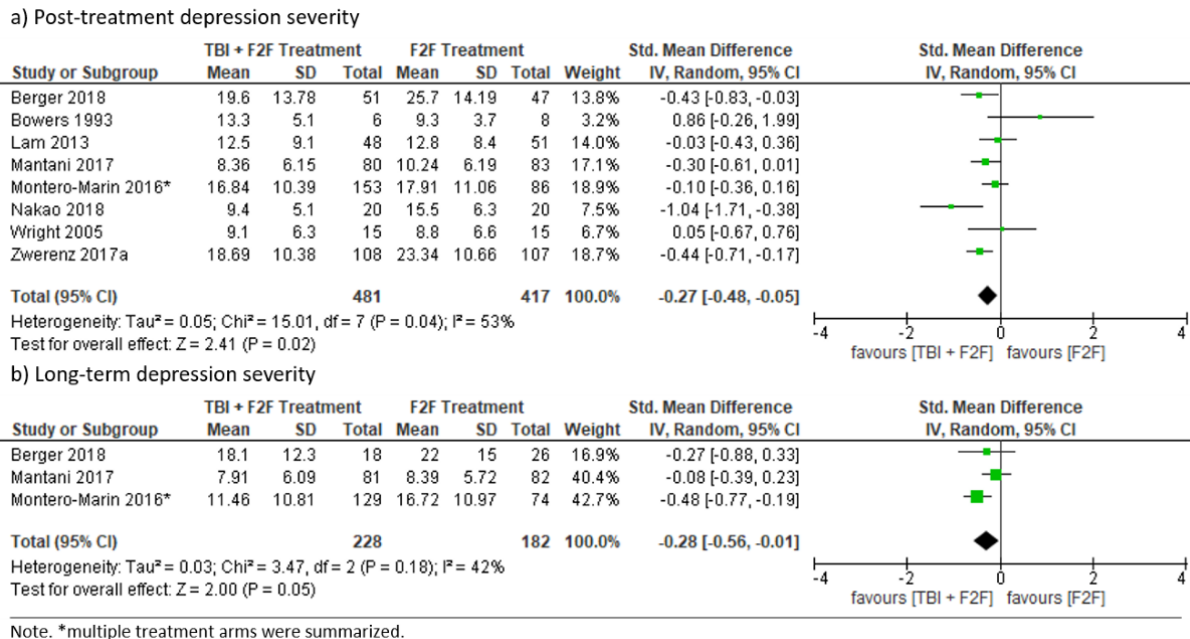
Figure 10. Forest plots for blended treatments (superiority trials).